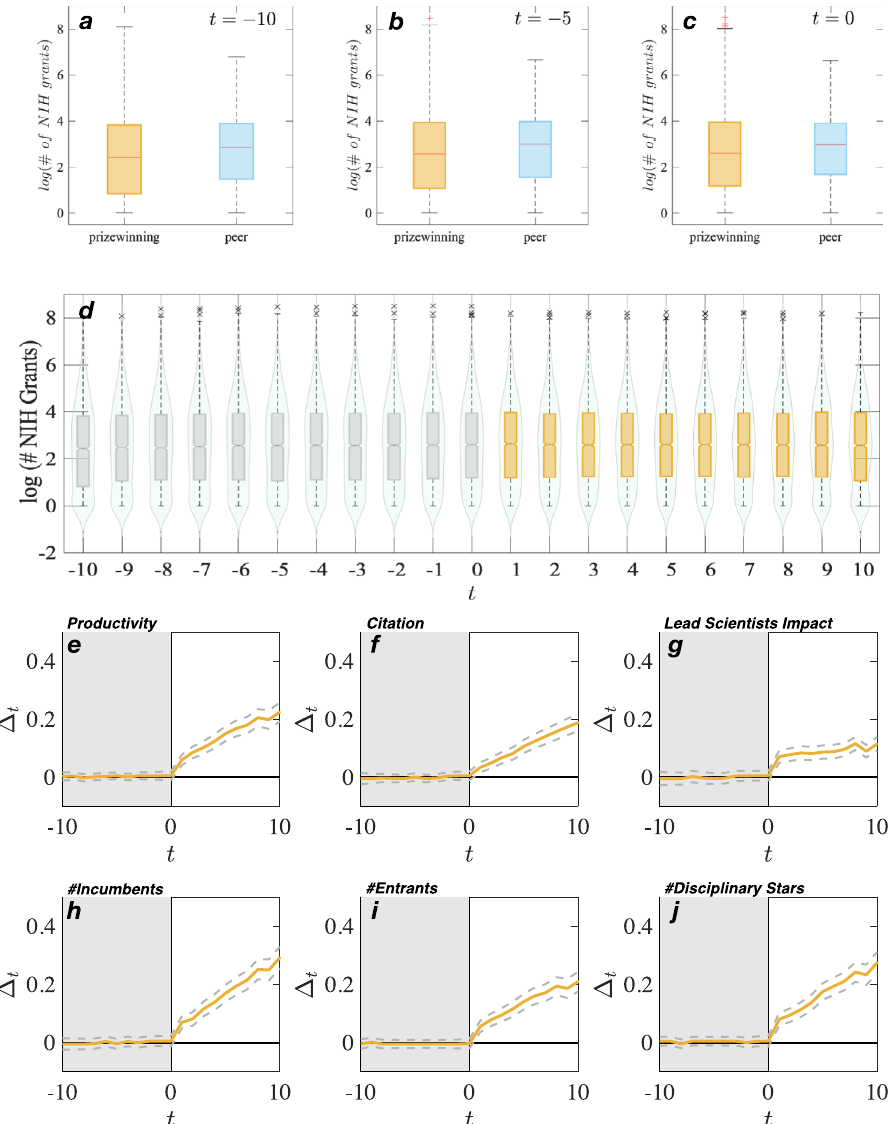
Fig. 3 Funding and extraordinary growth are statistically unrelated in NIH subsample. The analysis examines whether funding plays a role in the extraordinary growth of prizewinning topics. In the analysis, we fi nd a subset of 2853 prizewinning topics that were matched on six measures of growth and the receipt of NIH funding, which is publicly available. Repeating the main analysis that was done on the full sample of over 11,000 topics, we found that funding does not explain the extraordinary growth of prizewinning topics. First, a – c shows that prizewinning have statistically equivalent or less funding before the prize than matched topics. Second, d shows that the normalized number of NIH grants is largely fl at before (gray box) and after (gold box) the prizewinning event for the prizewinning topics. The center line of the box plot is the median of the normalized grants, box limits correspond to the data ’ s fi rst and third quartiles, notches represent 95% CI, and violin plots represent the data ’ s distribution. Third, plots e – j show that prizewinning topics grow relatively larger than expected after the prize year consistent with the main analysis with the full